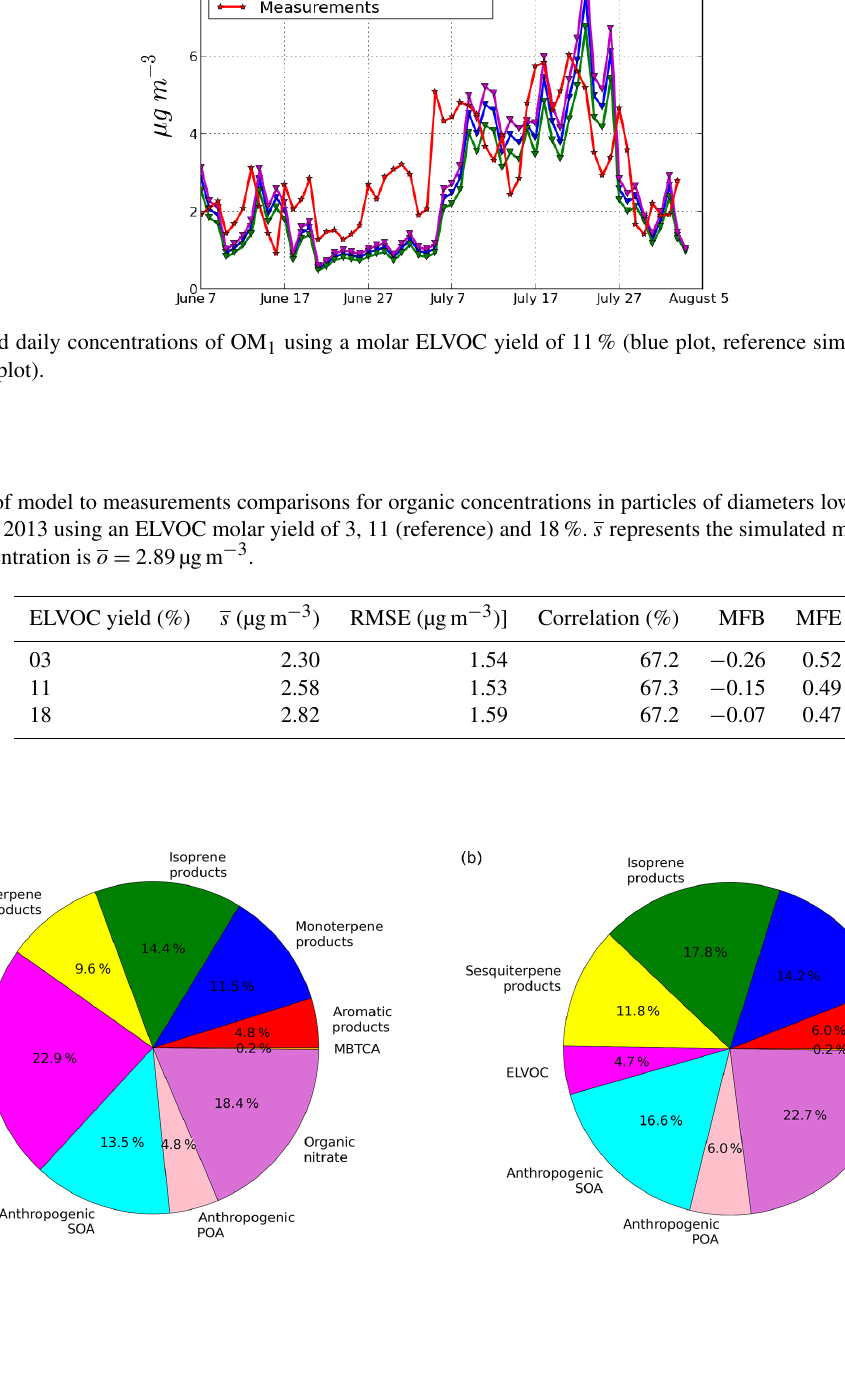
Figure D2. Simulated composition of OM 1 using the upper (a) and lower (b) bounds of ELVOCs molar